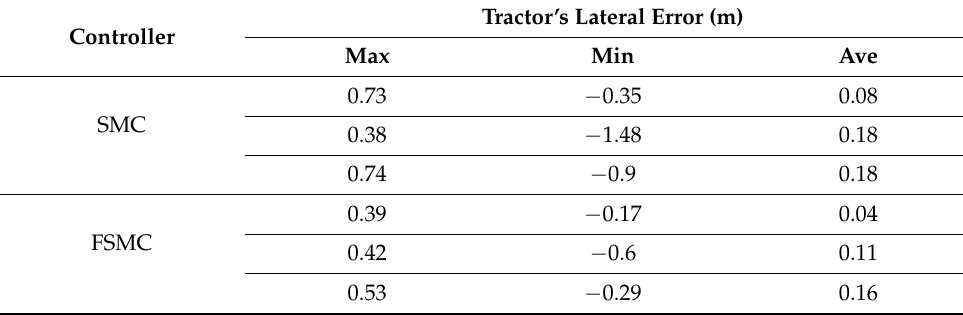
Table 3. Statistics of tractor path tracking error after going online.